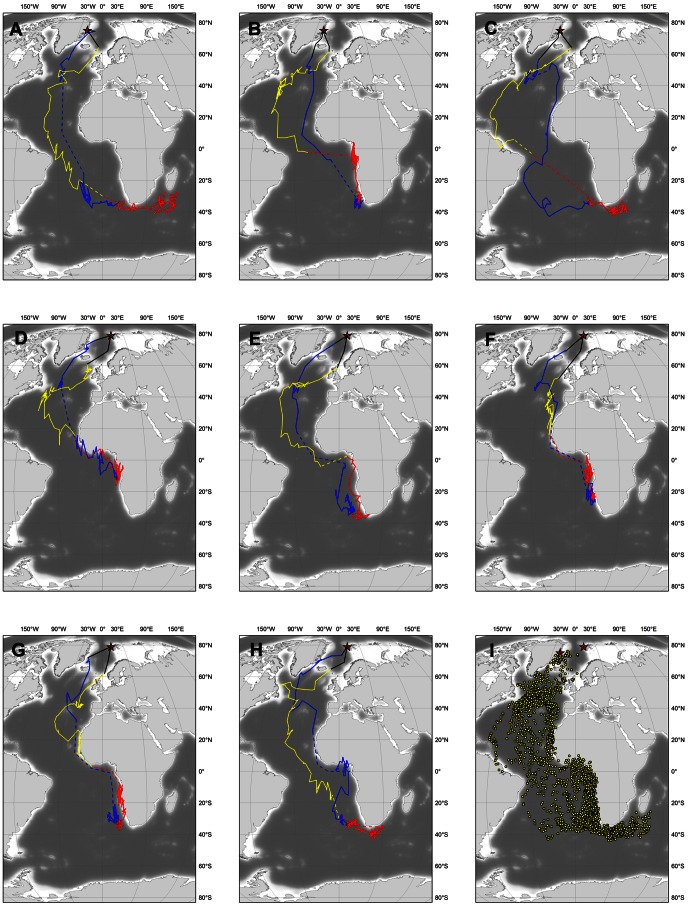
Flyways used by Long-tailed Skuas between their breeding grounds (red stars) and their wintering ground.(a–c) three males from north-east Greenland, (d–f) three males and (g–h) two females from Svalbard. Autumn movements (August–November) are in blue, winter movements (December–March) in red and spring movements (April–June) in yellow. Dashed lines represent interpolations (linear or parallel to the continents) for periods (equinox) when latitude could not be estimated. Black lines: same interpolations close to breeding grounds due to permanent daylight. The last panel (i) presents all raw positions (two per 24 h) obtained for these eight birds over one year.